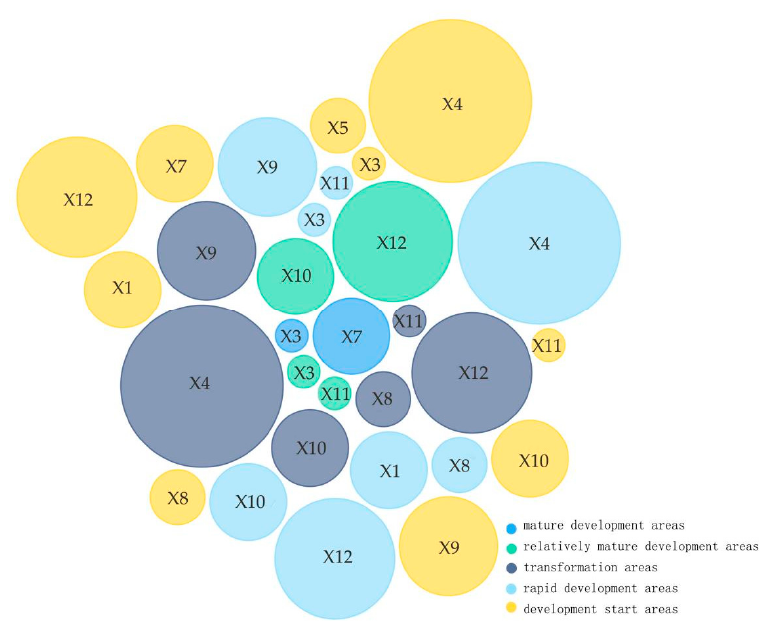
Figure 12. Urban green space planning and policy analysis.